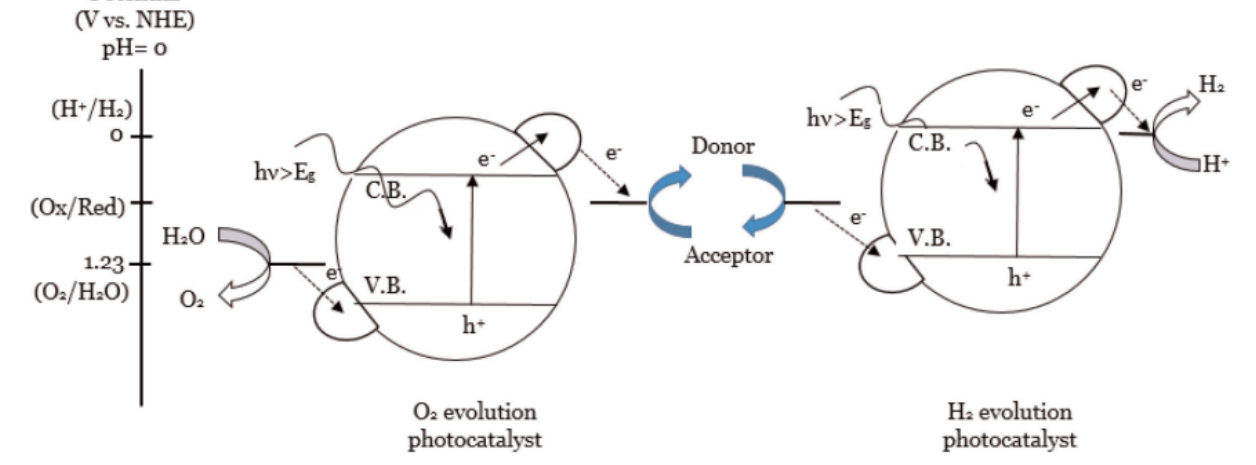
Figure 14. Schematic diagram for photocatalytic water splitting using a Zschemed photocatalytic system [2]. Reprinted with permission from ref. [2].